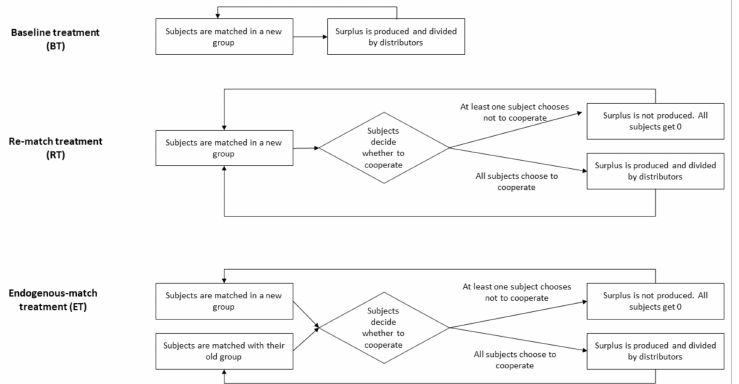
Figure 1. Experimental setup. In both Re-Match Treatment (RT) and Endogenous-Match Treatment (ET), during the first three rounds cooperation was